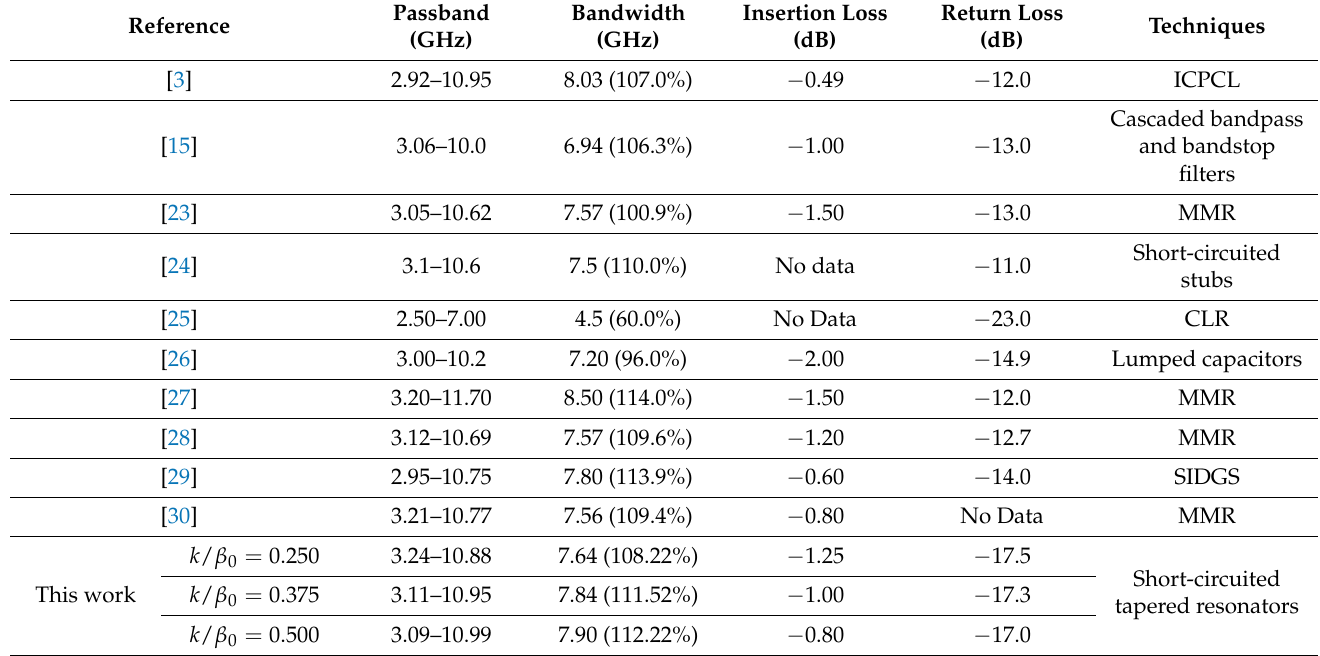
Table 4. Performance comparison with other UWB filter